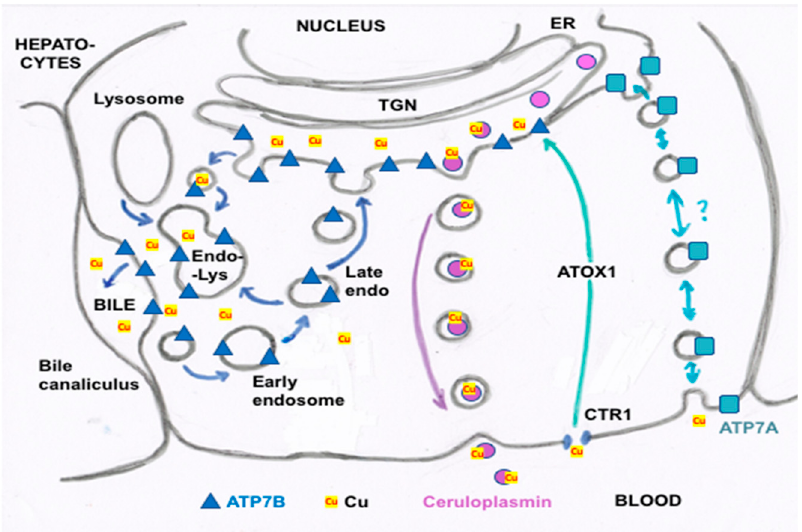
Figure 4. Summary of proposed steps involved in the movement of cu into bile and secreted by hepatocytes. Based mainly on the data, reviews and figures provided by Polishchuk and Polishchuk [26] and Stewart et al. [27]. Cu ions enter hepatocytes from plasma proteins via copper transporter 1 (CTR1) and at least one other as yet unidentified transporter, and are carried via the chaperone ATOX1 to ATP7B (blue triangles) in the transGolgi network (TGN). In the lumen of the TGN, Cu will be incorporated into apoceruloplasmin (apoCp) (violet circles), forming holoCp, and be released into the blood plasma by exocytosis (center right of the figure) across the “basolateral” hepatocyte membrane. In the absence of excessive Cu not otherwise incorporated into Cp and endogenous Cu-dependent proteins and mitochondria, TGN Cu in the lumen will be exported to the bile canaliculi that are formed between hepatocyte apical membranes, leading to the gall bladder and bile duct. This happens through the budding of vesicles from the TGN that contain Cu and may also contain ATP7B. These fuse with late endosomes also containing ATP7B as well as lysosomes (to form the endo-lysosomal compartment), which then fuses with the apical hepatocyte membrane at a canaliculus (left side of figure). This releases Cu that was present in the vesicular bodies and also can lead to ATP7B being part of the apical membrane. The latter is particularly important in the presence of excess Cu, which can then flow from ATOX1 directly to ATP7B that pumps it into the bile canaliculi. Small amounts of the Cu e ffl ux “pump”, ATP7A (blue squares), are also expressed in hepatocytes (far right of the figure), and may also contribute to Cu that exits hepatocytes and enters the blood plasma, to bind to proteins like albumin in the exchangeable plasma Cu pool. Based on what is known in other cells, the much less abundant ATP7A in hepatocytes would either transfer some Cu in the TGN into secretory vesicles (for exocytosis), and / or tra ffi c it in vesicles to the basolateral membrane to pump Cu in the cytosol (on ATOX1) into the blood plasma, following which ATP7A would recycle back to the TGN.